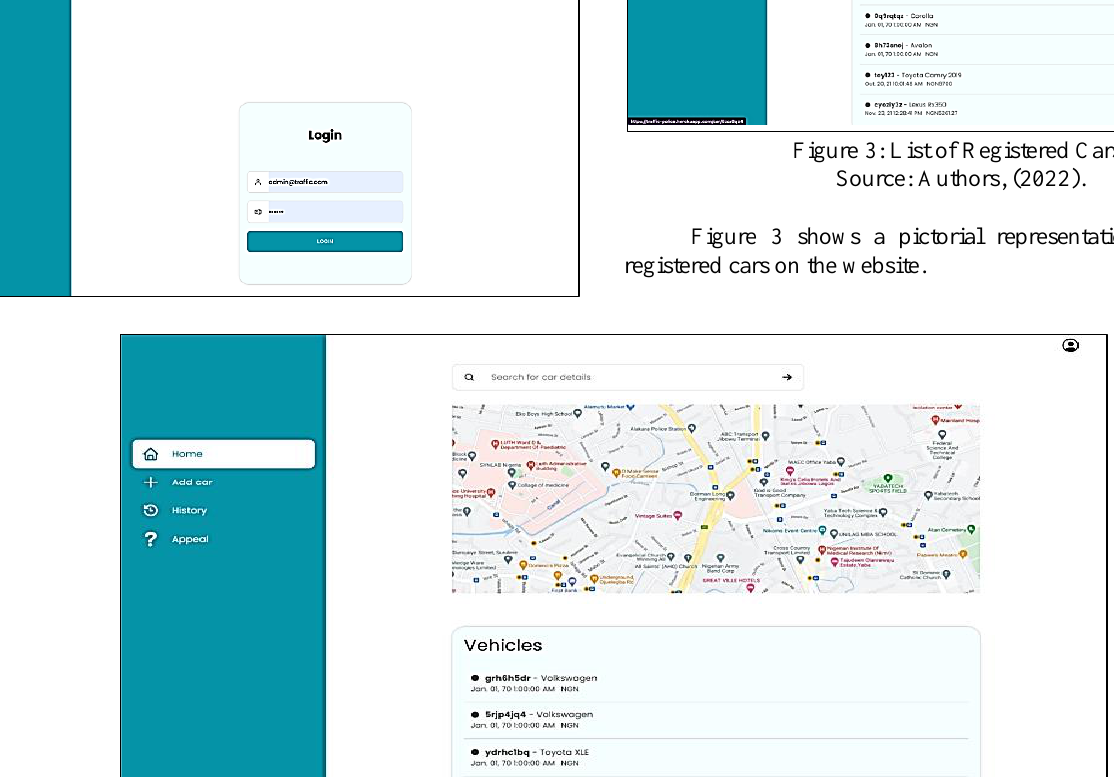
Figure 4: Details of Registered